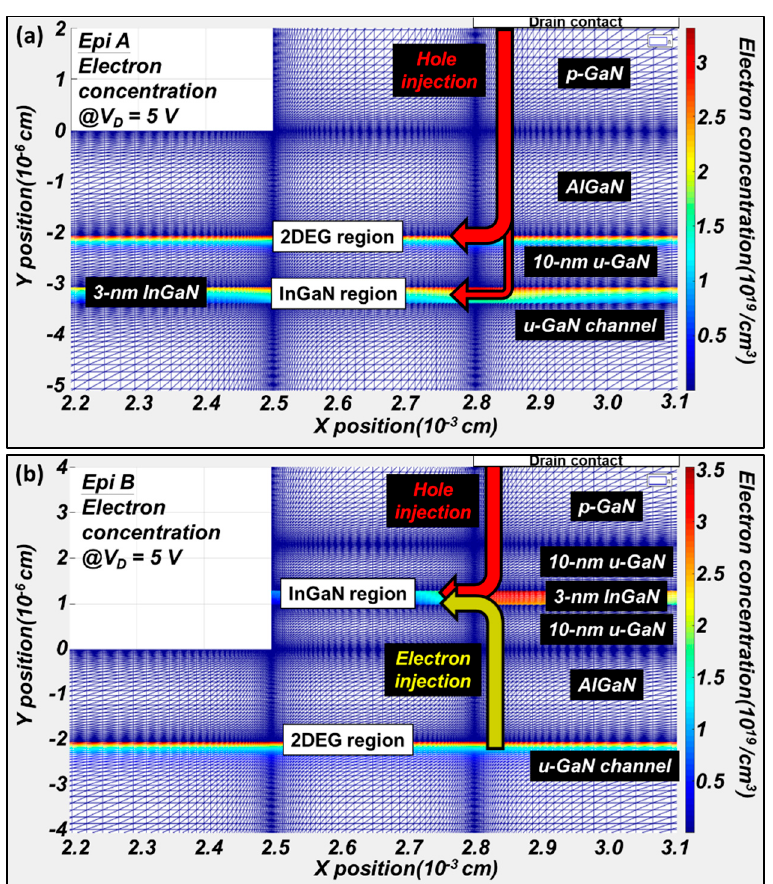
Figure 2. Simulation of radiative recombination rate in the light-emitting region of LE-HEMT on ( a ) Epi A and ( b ) Epi B structures .